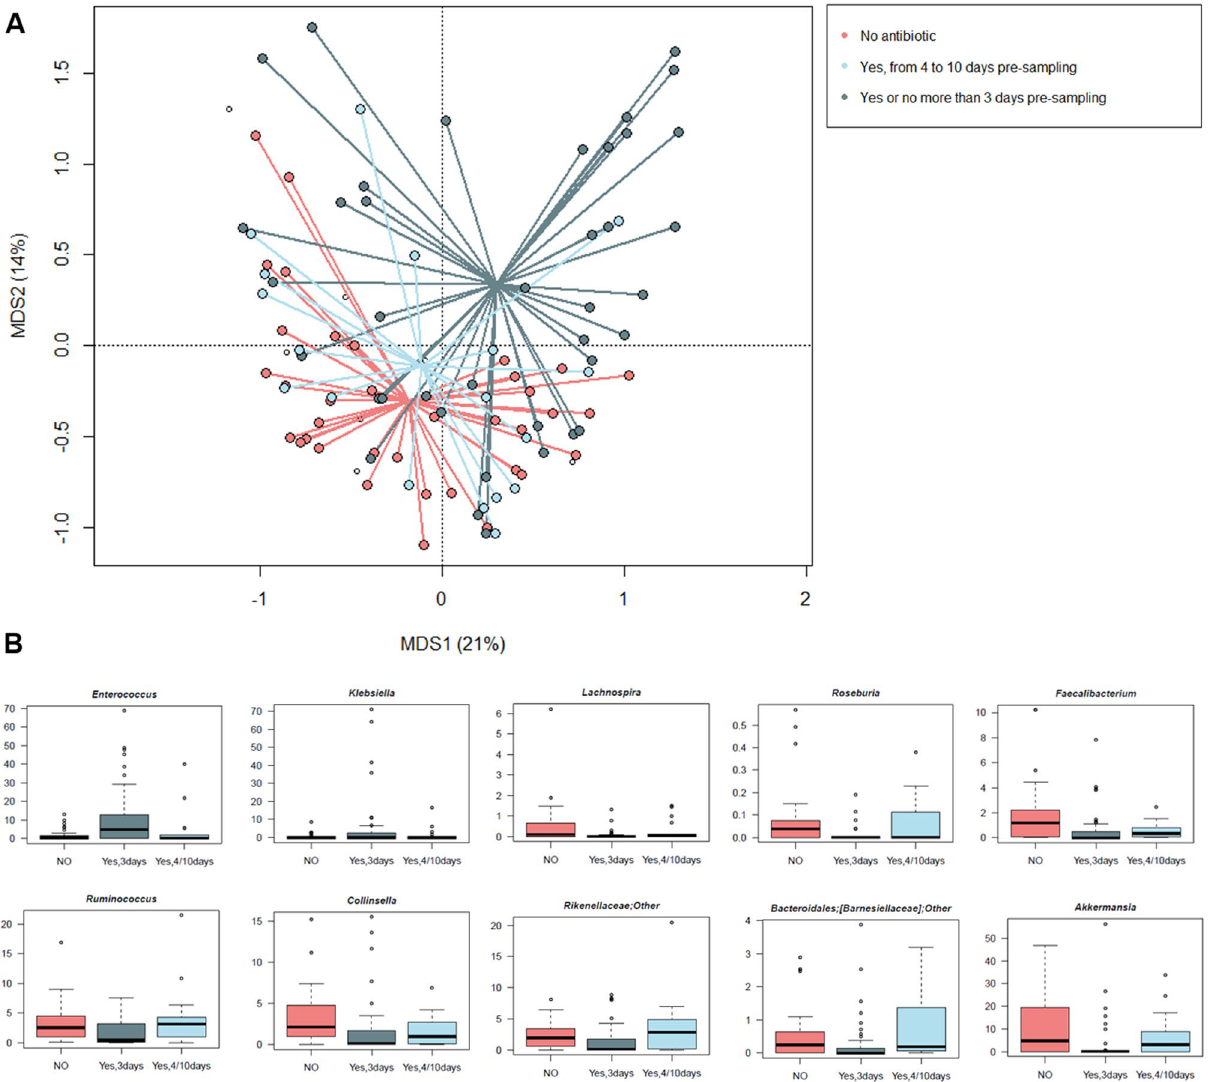
Figure 6. Impact of antibiotics administration on the gut microbiota of SCI patients. ( A ) Principal Coordinates Analysis based on Bray–Curtis distances between the genus-level microbial profiles of SCI patients according to antibiotics administration and timing (i.e., no antibiotic therapy, and therapy in the 3 days or between 4 and 10 days before fecal sampling). A significant separation among groups was found (p = 0.001, permutation test with pseudo-F ratios). ( B ) Box plots showing the distribution of the relative abundance values of discriminant genera. p ≤ 0.05, Kruskal–Wallis